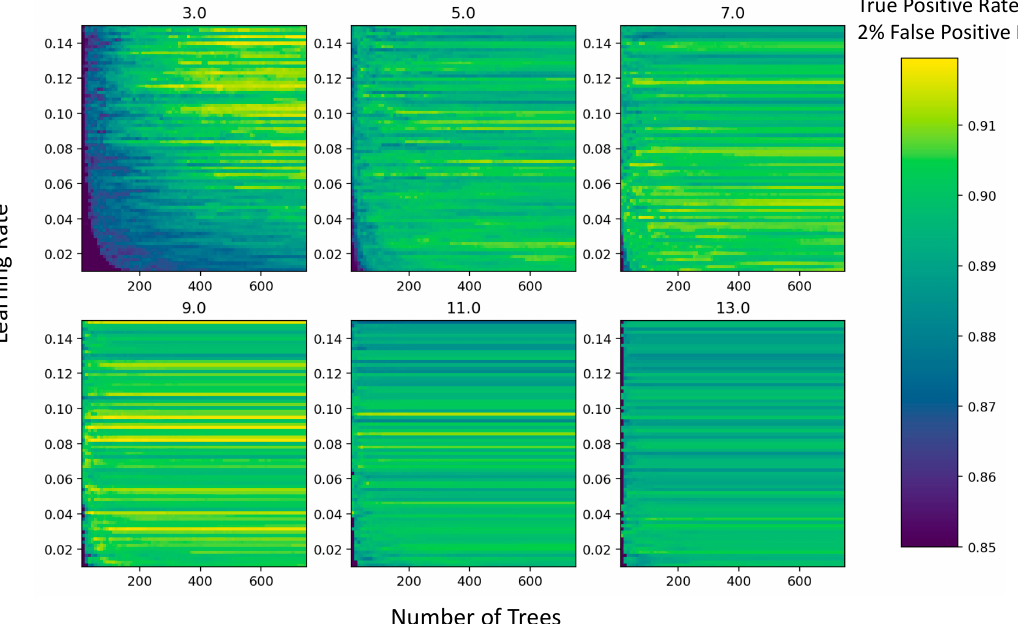
Figure 3. Model performance as a function of the number of decision trees and the learning rate of the gradient boosted regression model. The color indicates the model performance, calculated as the true positive rate at a 2% false positive rate, of different gradient boosted regression models, plotted according to their interaction depth, the number of trees, and the learning rate. The different interaction depths vary among the plots and are shown as the title of the plot, the numbers of trees allowed in the model are the x-axes of all plots, and the learning rates are the y-axes of all plots.